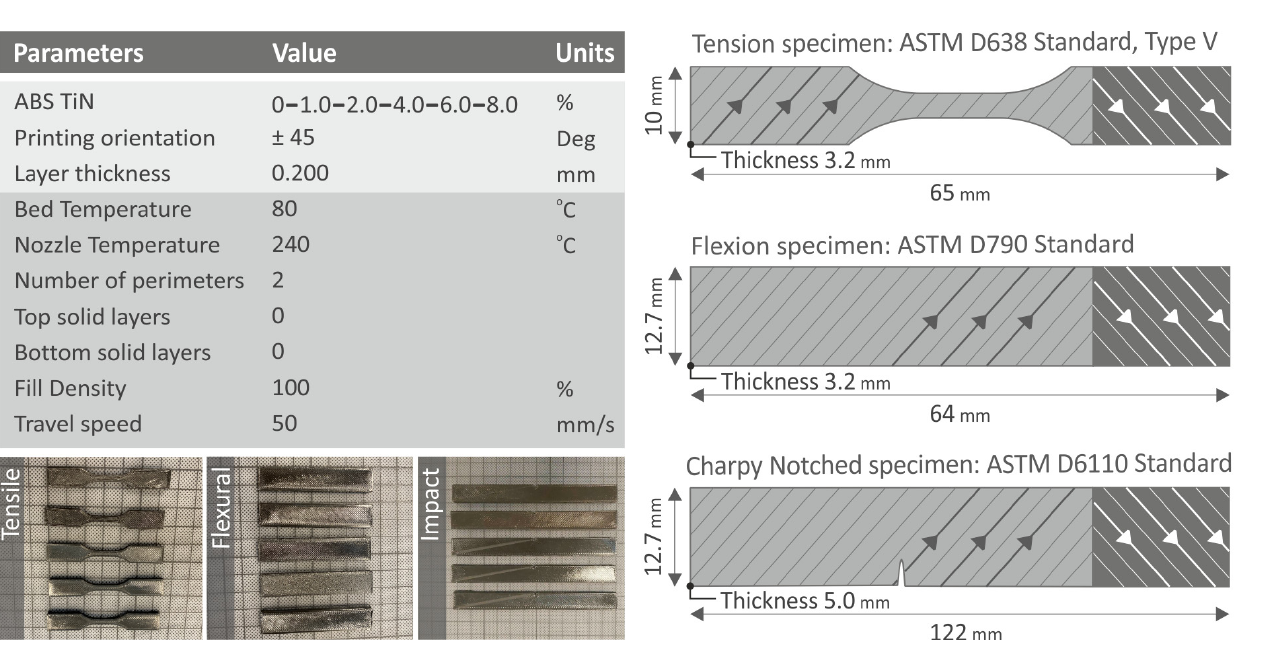
Figure 3. 3D-printing parameters for the manufacturing of specimens. The specified dimensions of fabricated specimens for each mechanical test are presented on the right side, along with the respective international standard the specimens are confronting, and it was followed in the work.